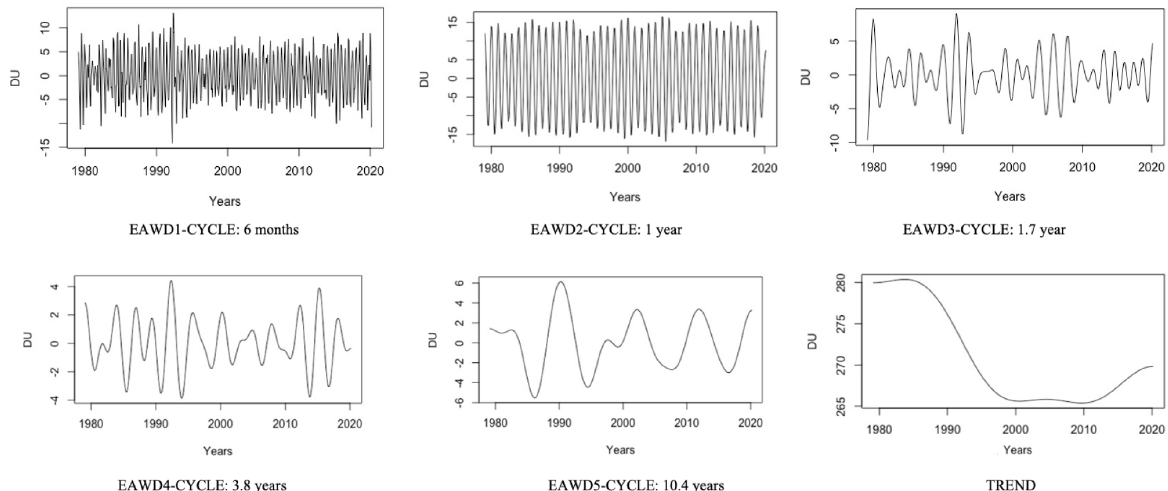
Figure 9. Réunion total ozone time series EAWD decomposition results.